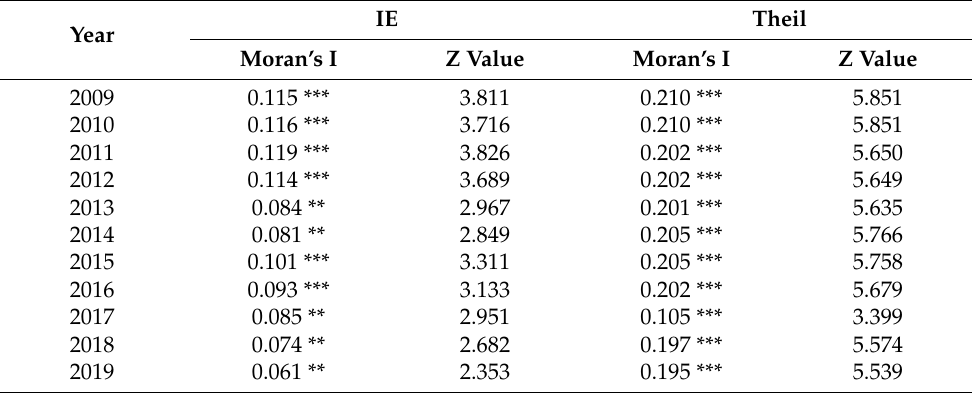
Table 4. Digital economy and the urban–rural income gap Moran index